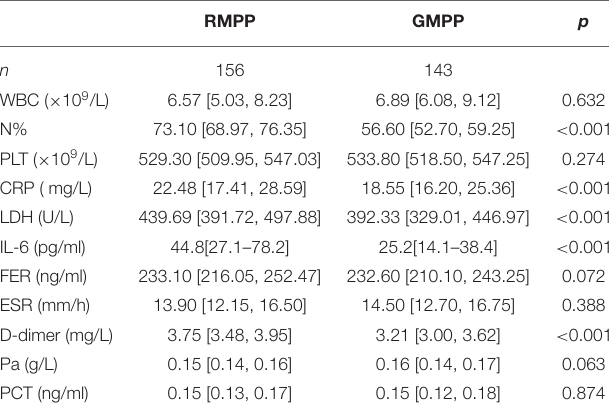
TABLE 2 | Laboratory data of GMPP and